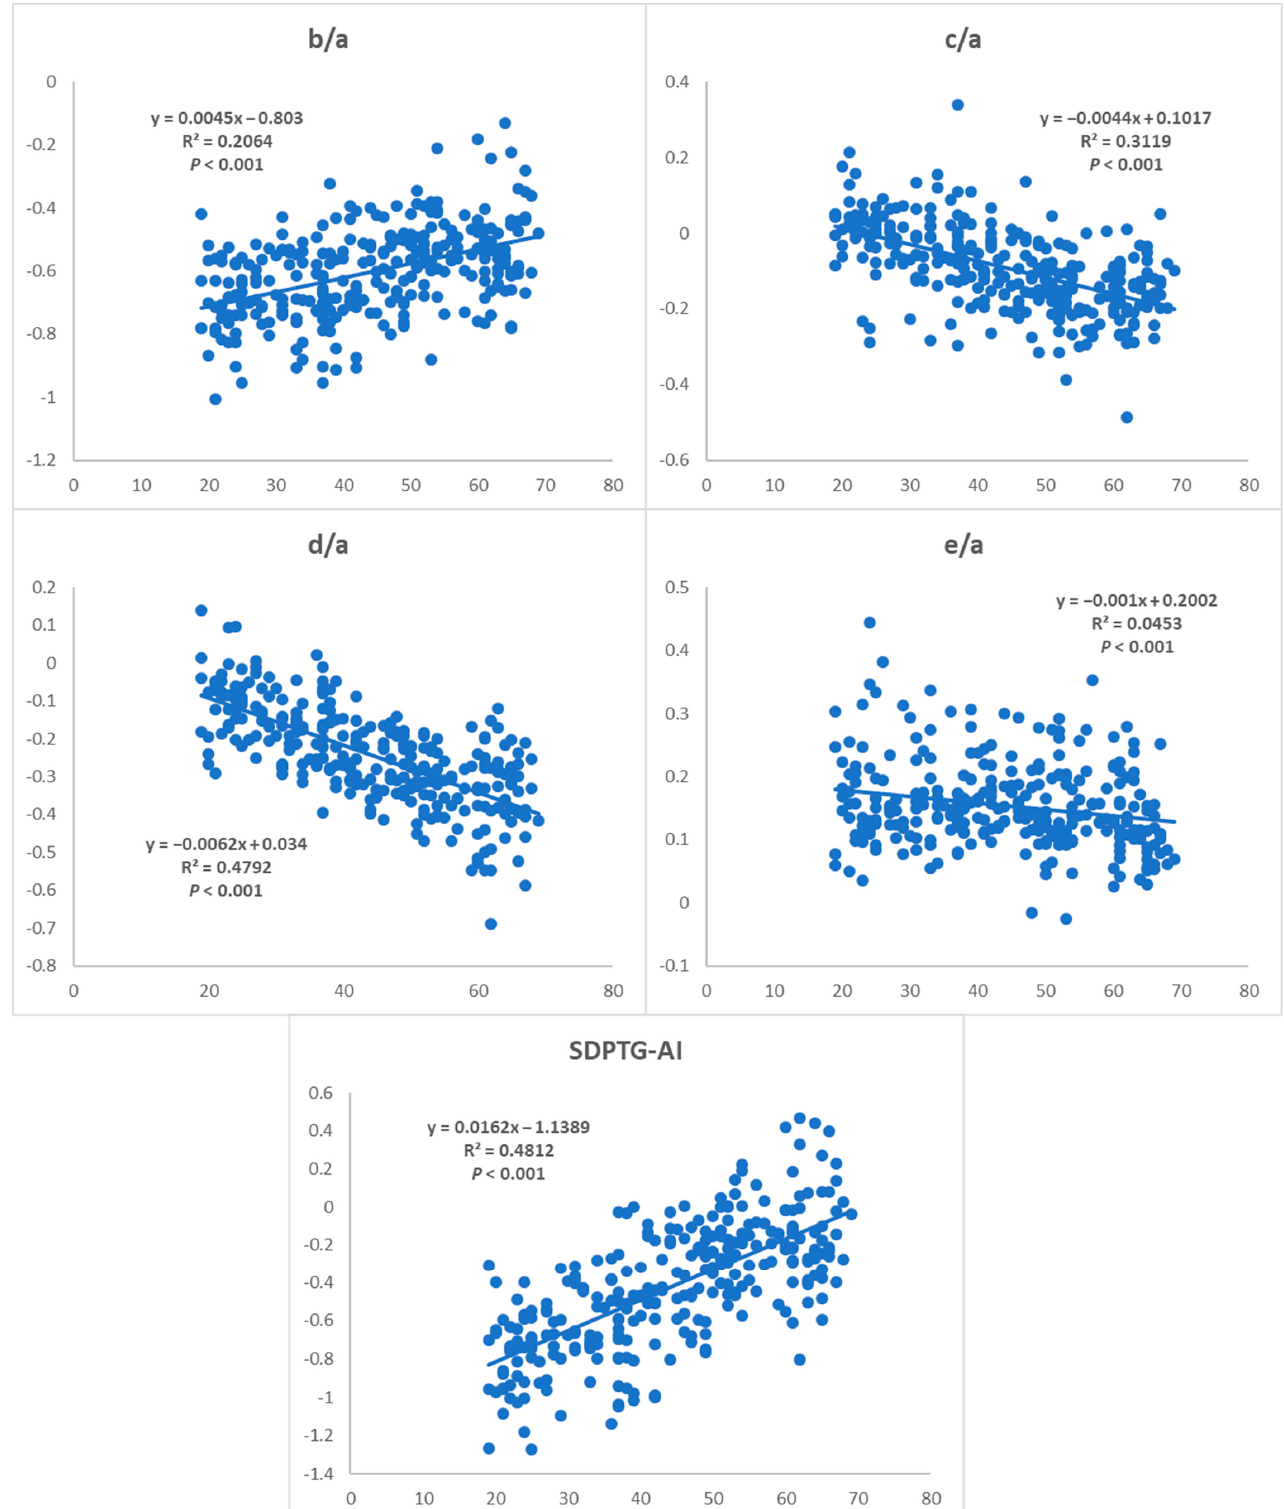
Figure 3. Variations in second derivative photoplethysmogram (SDPTG) indices with age in healthy Korean groups.